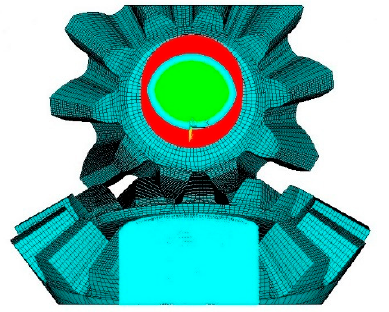
Figure 3. The finite element model of straight bevel gear pair.